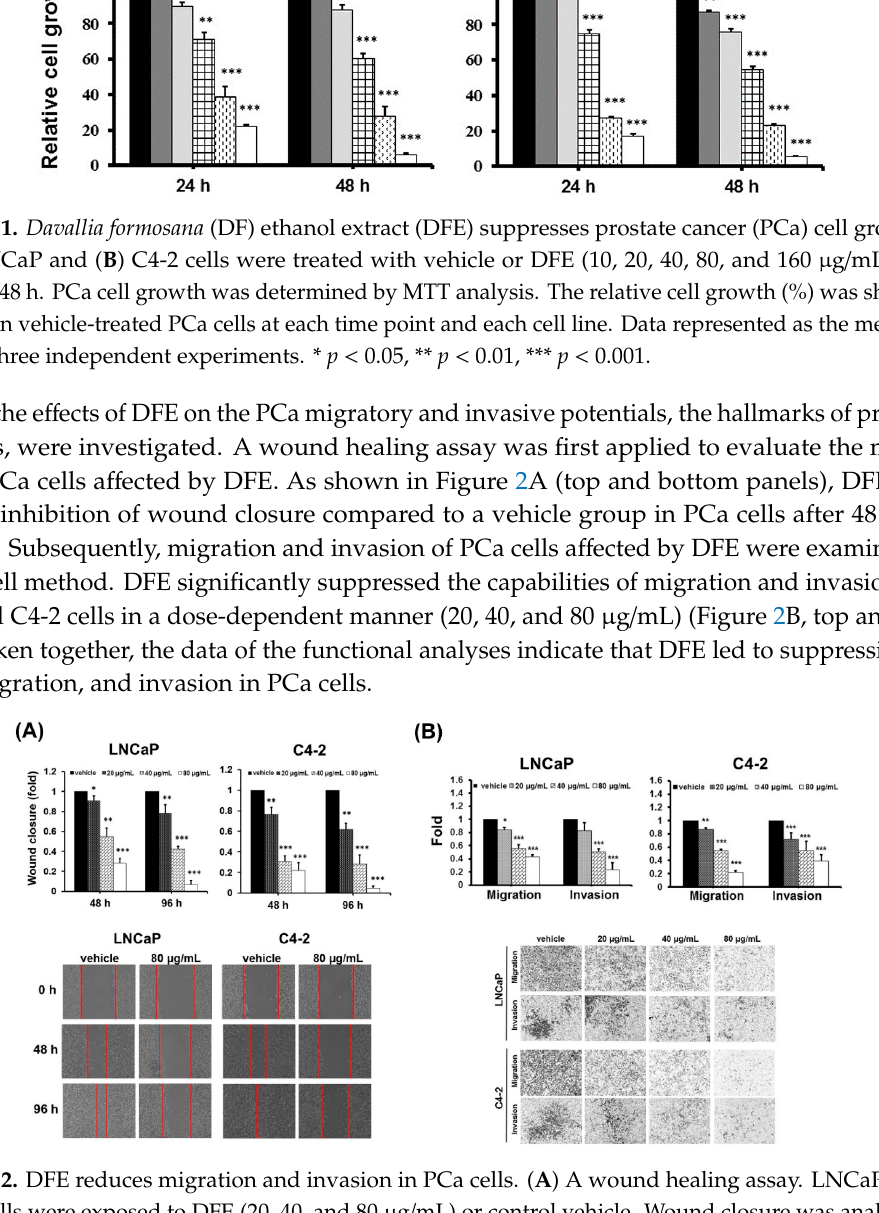
Figure 2. DFE reduces migration and invasion in PCa cells. ( A ) A wound healing assay. LNCaP and C4-2 cells were exposed to DFE (20, 40, and 80 µg/mL) or control vehicle. Wound closure was